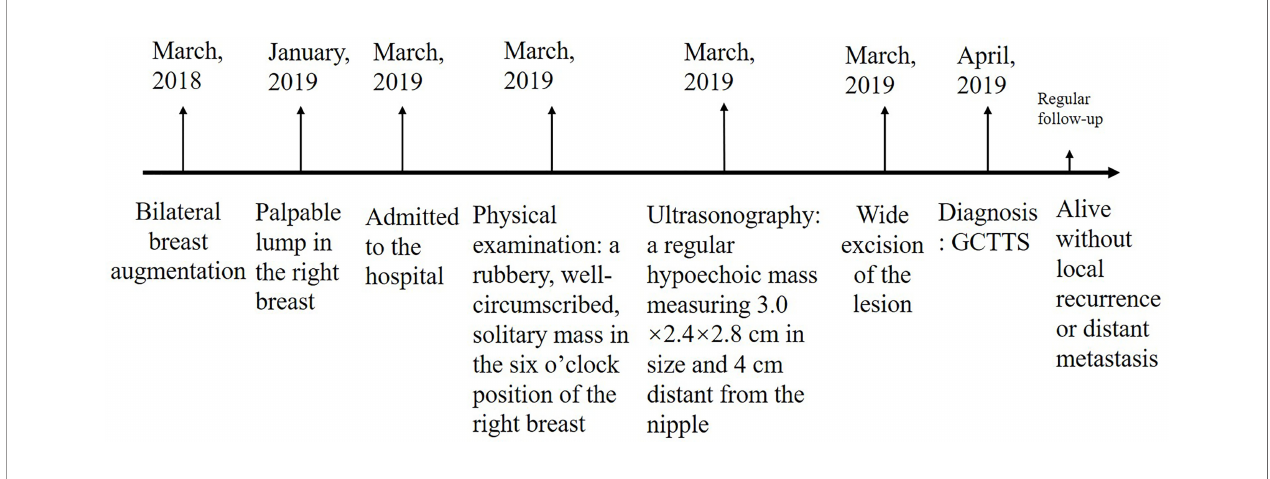
( Figure 3F ), and CD10. P63 was focally positive in mononuclear cells. Ki67 was positive in about 10%. The tumor cells were negative for desmin, CD34, S-100, EMA, PCK, TLE-1, CK5/6, HMB45, ALK, and CD30. In terms of fl uorescence in situ hybridization (FISH) detection for the translocation of CSF1 gene and USP6 gene, the results were negative ( Figure 4 ).